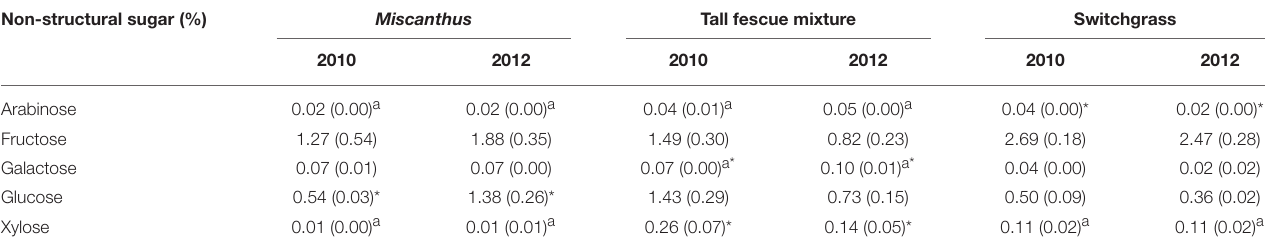
TABLE 2 | Percent of each non-structural sugar in Miscanthus , the tall fescue mixture, and switchgrass grown in 2010 and 2012 [ n = 3; mean (1 SD )]. Non-structural sugar